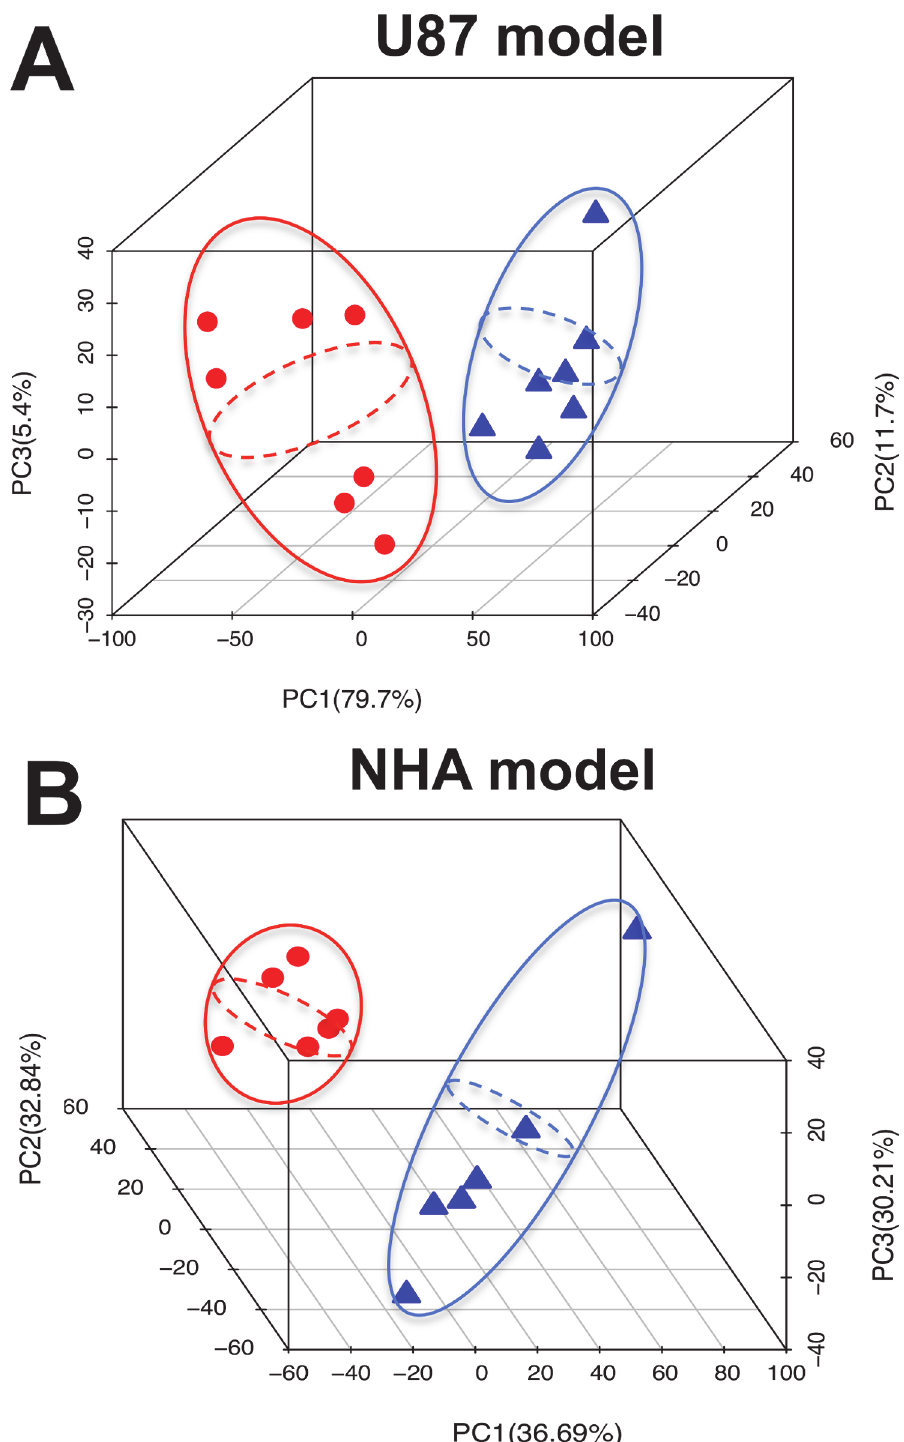
Fig 2. Score Plots of PCA reveal that IDHwt and IDHmut groups are clearly separated. The score plots of the PCA applied to the 1 H-MRS spectra of cell extracts from IDHwt ( Δ blue) and IDHmut ( Ο red) cells for U87 (A) and NHA (B)